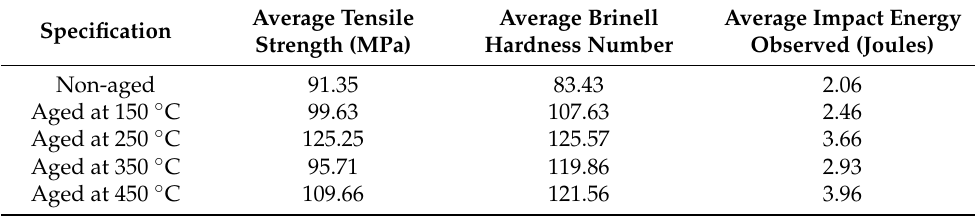
Table 4. Average tensile strength, impact energy and hardness of Al7075-WC